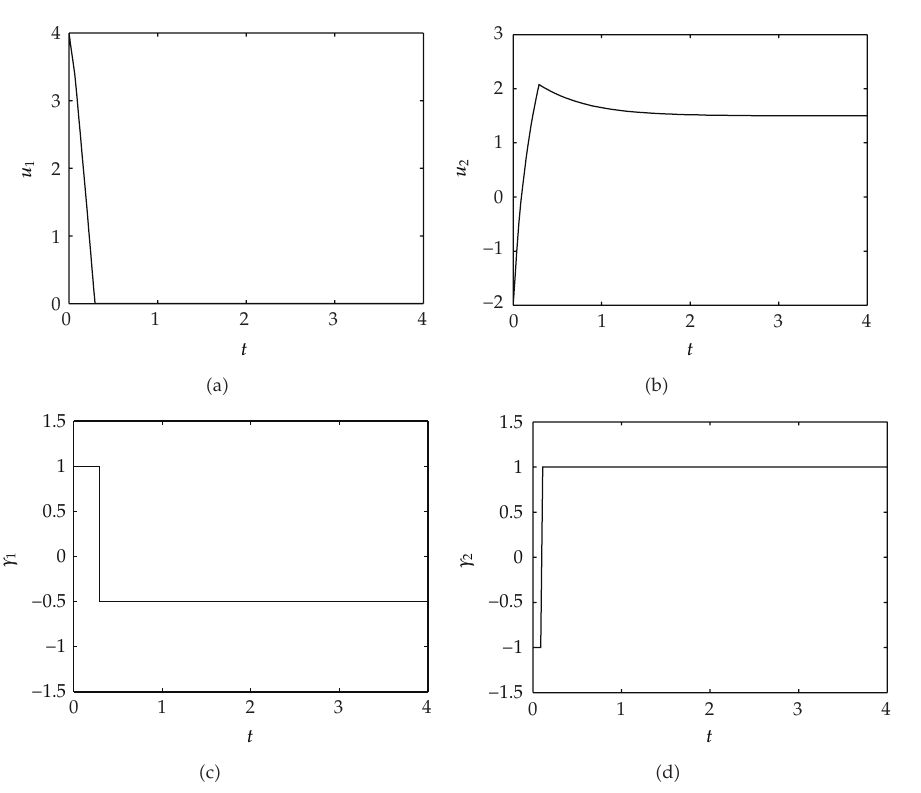
Figure 3: Transient behavior of (cid:5) u 1 ,u 2 (cid:6) and (cid:5) γ 1 ,γ 2 (cid:6) for I (cid:7) (cid:5) 0 , 0 (cid:6) T , u 0 (cid:7) (cid:5) 6 , − 6 (cid:6) T